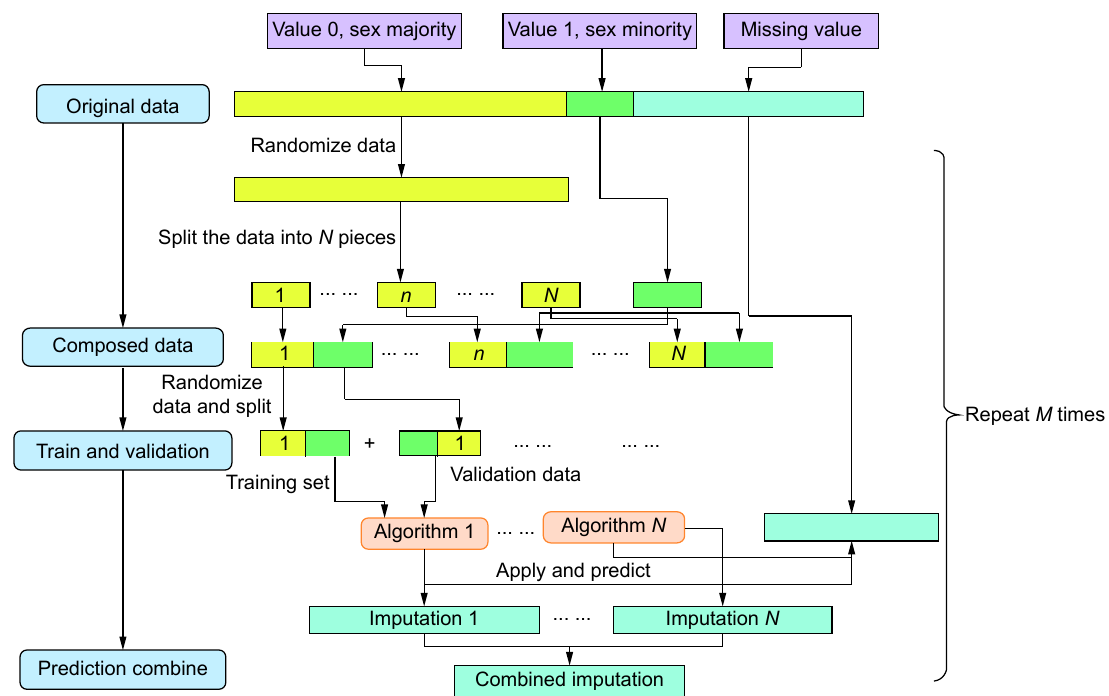
Fig. 1 Missing value imputation of sexual minority orientation.